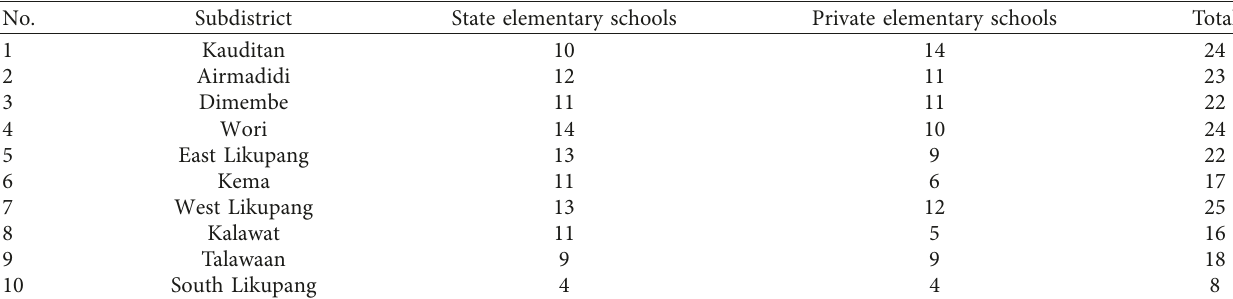
Table 1: State and private elementary schools in North Minahasa.